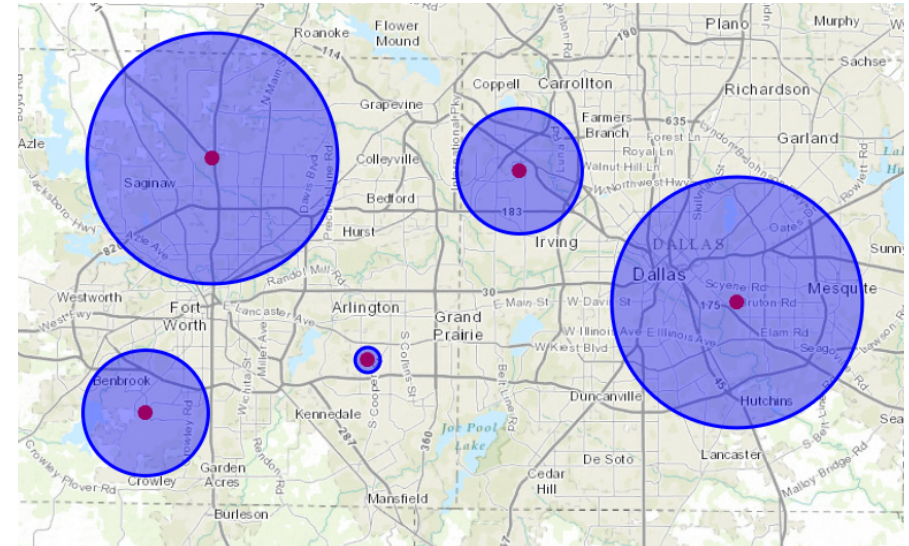
Figure 3. An example of buffering analysis (adapted from [31]).